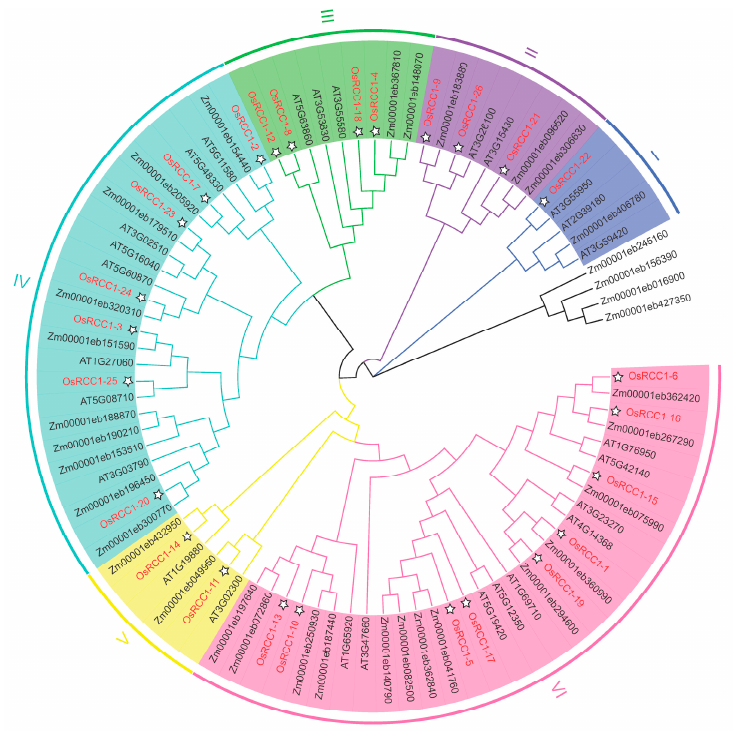
Figure 1. Phylogenetic analysis of OsRCC1s and their homologs from various organisms. AT represents A. thaliana , Zm represents Z. mays , and Os represents O. sativa L. The phylogenetic tree was generated using the NJ method by MEGA7. OsRCC1s are classified into 6 groups (Group I–VI) and distinguished by different colors.